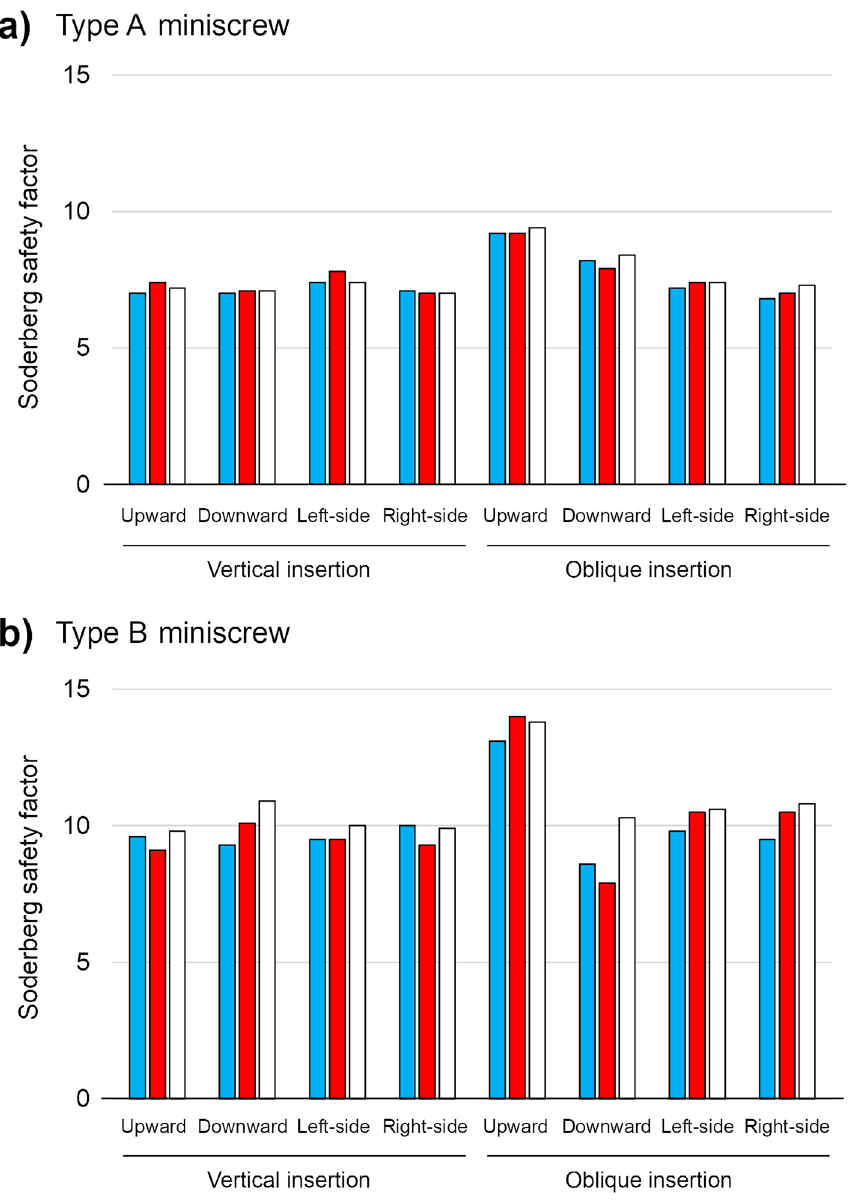
Figure 5. Soderberg safety factor values for different types of miniscrews when the miniscrew (placed vertically or obliquely) was loaded in various directions. ( A ) Type A miniscrew, ( B ) Type B miniscrew. 1.5 mm, 2.0 mm, 3.0